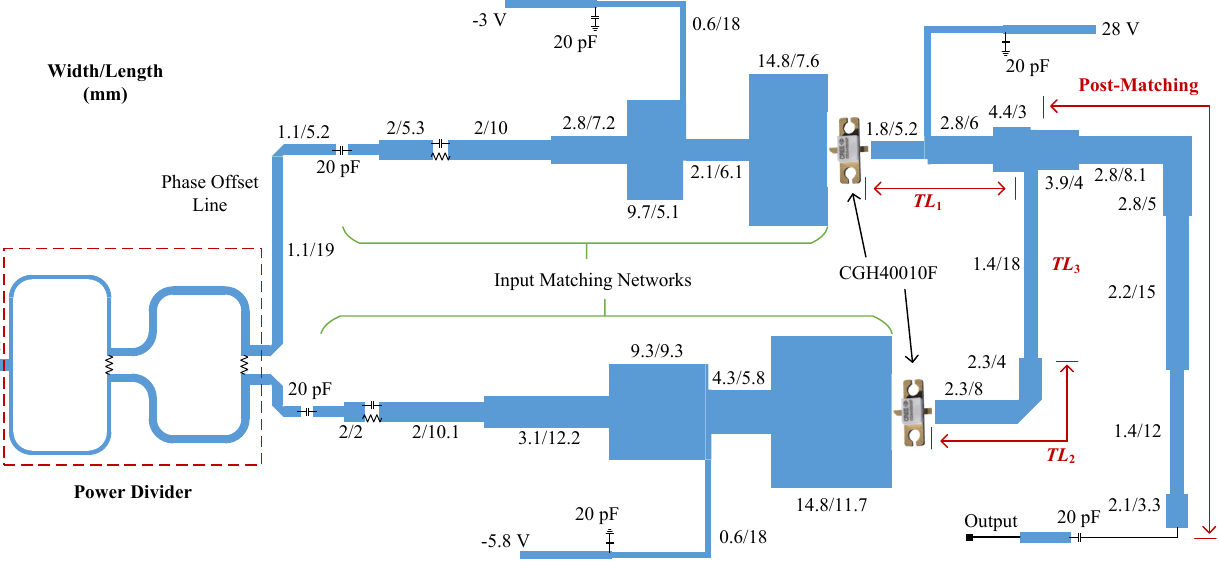
Figure 3. Schematic of the designed DPA together with the dimensions of the utilized passive